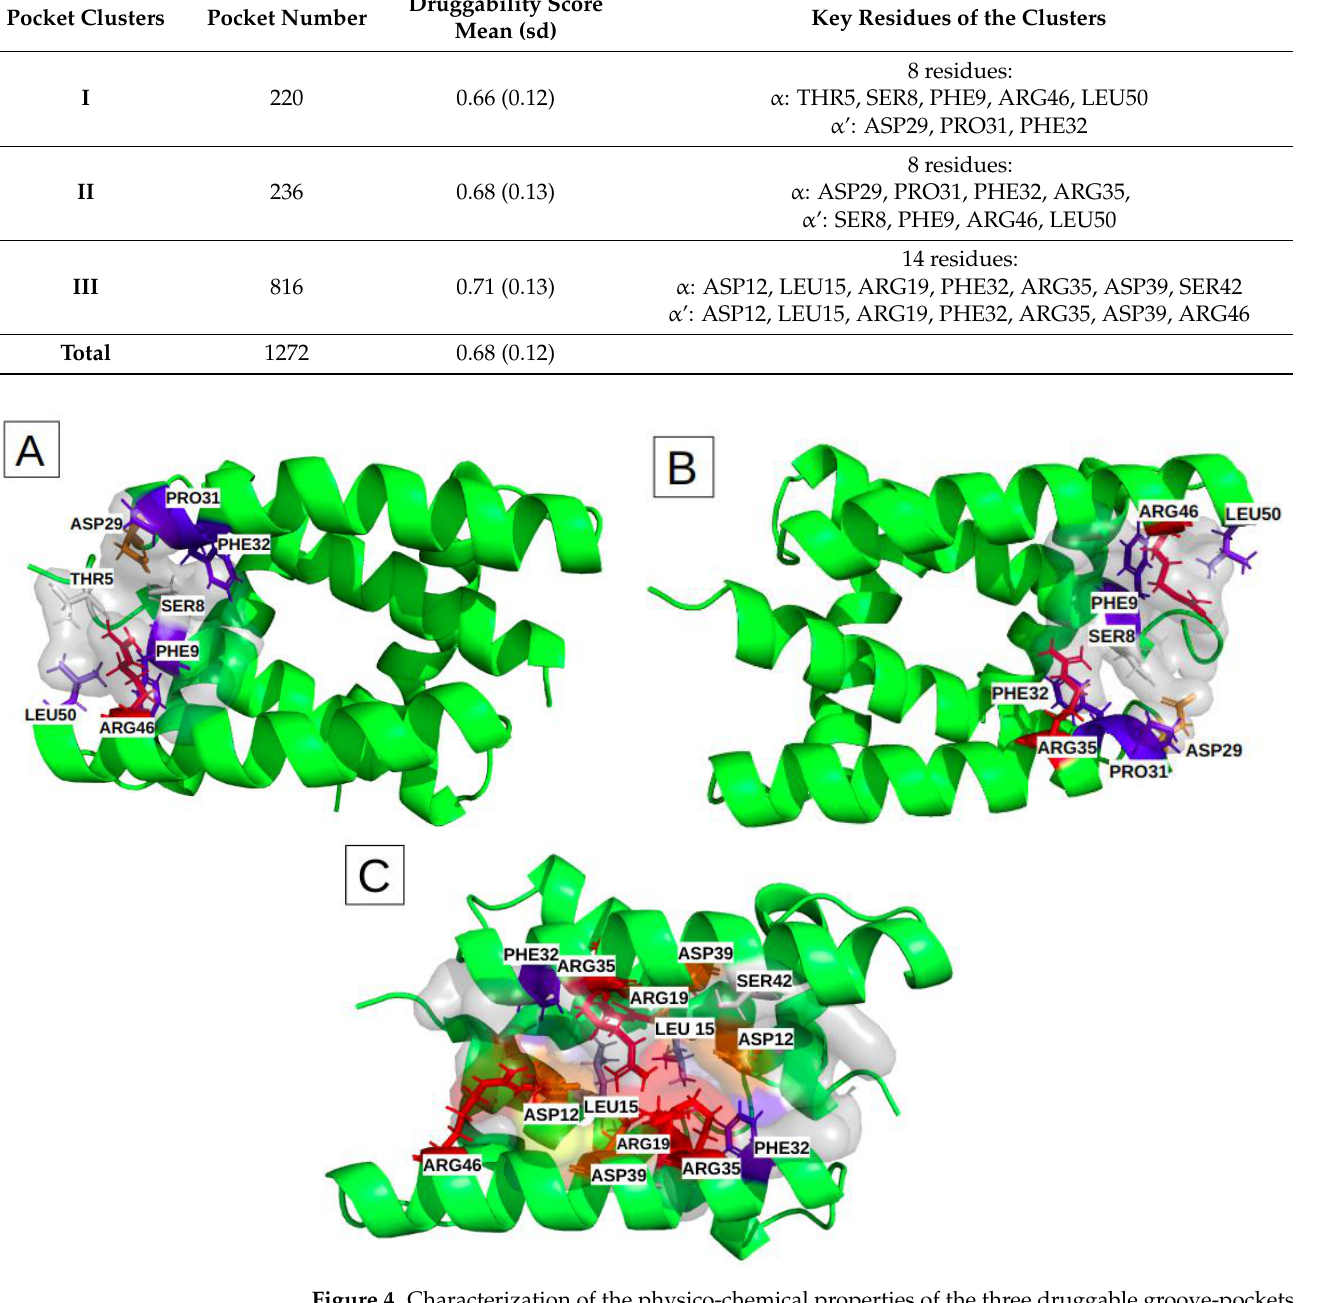
Figure 4. Characterization of the physico-chemical properties of the three druggable groove-pockets identified according to the classification into three clusters: the most frequent residues are colored in red and orange for the positively and negatively charged ones, in blue and slate-blue for the aromatic and aliphatic ones, and in white for the polar. ( A ) is cluster I, which is a small pocket at the end of the groove, ( B ) is cluster II, which is a small pocket located at the opposite side of cluster I. ( C ) is a large pocket identified on cluster III, located in the center of the groove, recovering a large groove interface.